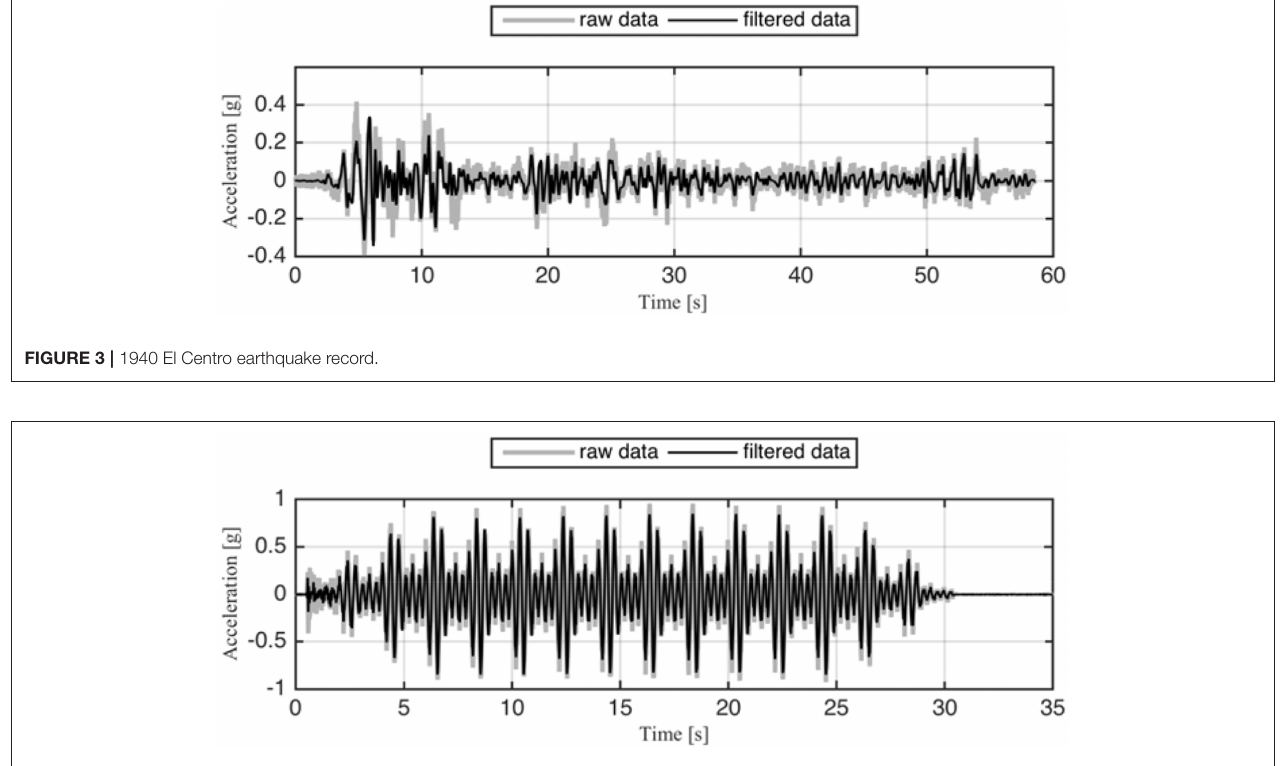
FIGURE 4 | Harmonic base excitation.